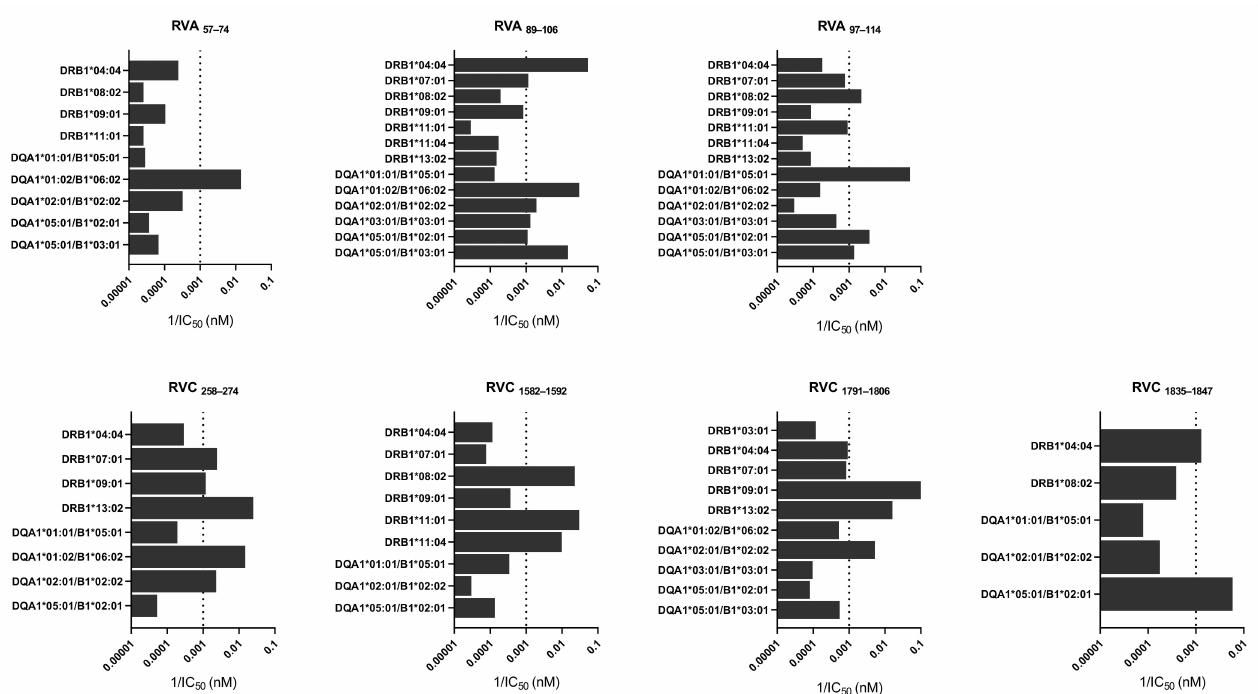
Figure 3. Binding affinity of rhinovirus (RV) peptides to human leukocyte antigen class II (HLA-II) molecules. The figure depicts the HLA-DR and -DQ molecules with detectable binding affinity for each of RV-specific CD4 T cell epitopes (IC 50 < 40,000 nM). Binding affinity is given as 1/IC 50 value (nM), as determined by competitive inhibition binding assays (details in Materials and Methods). Data is expressed as mean 1/IC 50 obtained from three independent assays. The vertical line represents the threshold used as selection criteria for positive binding (IC 50 < 1000 nM). Data used to generate the figure is provided in Table